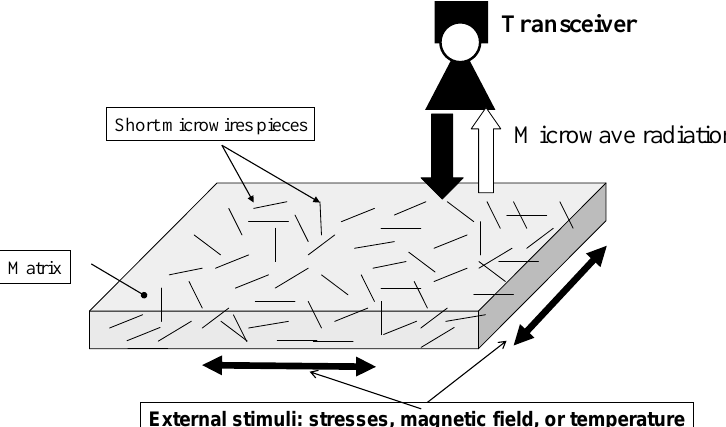
Figure 19. Free-space microwave sensing technique using embedded short ferromagnetic microwires